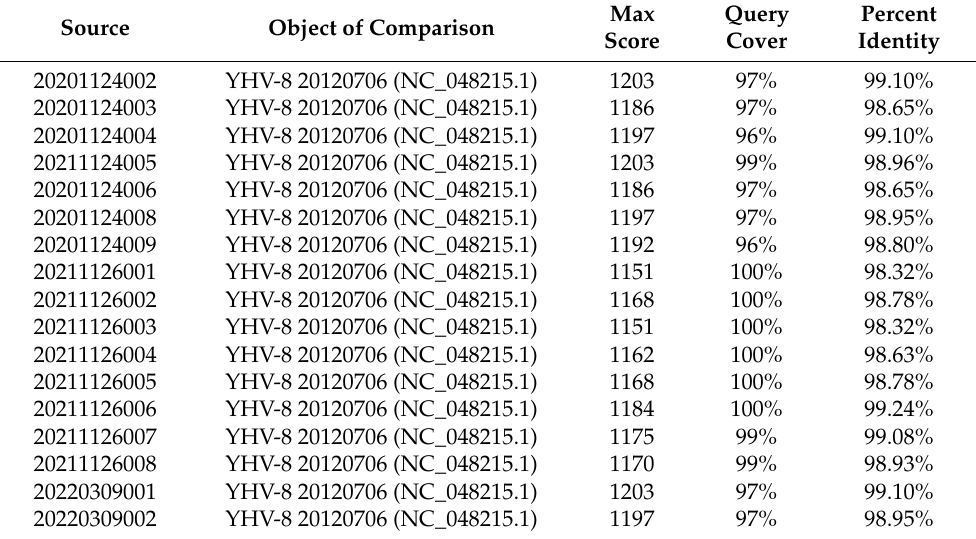
Table 4. Alignment of the open reading frame 1b (ORF1b) nucleotide sequence of yellow head virus genotype 8 (YHV-8) isolated from wild P. chinensis with the corresponding sequence of YHV-8 20120706 previously isolated from farmed P. chinensis